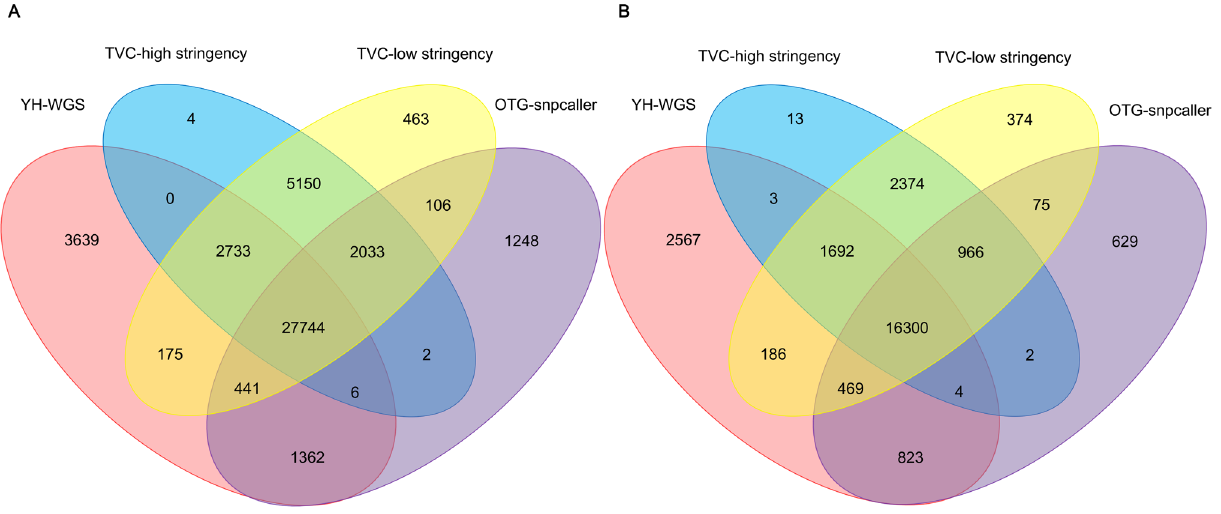
Figure 5. Venn diagrams of WGS, TVC high stringency, TVC low stringency and OTG-snpcaller. (A) Data from the TP00005 library. (B) Data from the TP00010 library. OTG-snpcaller exhibits more overlap (above 75%) with YH-WGS than both TVC high stringency and TVC low stringency.